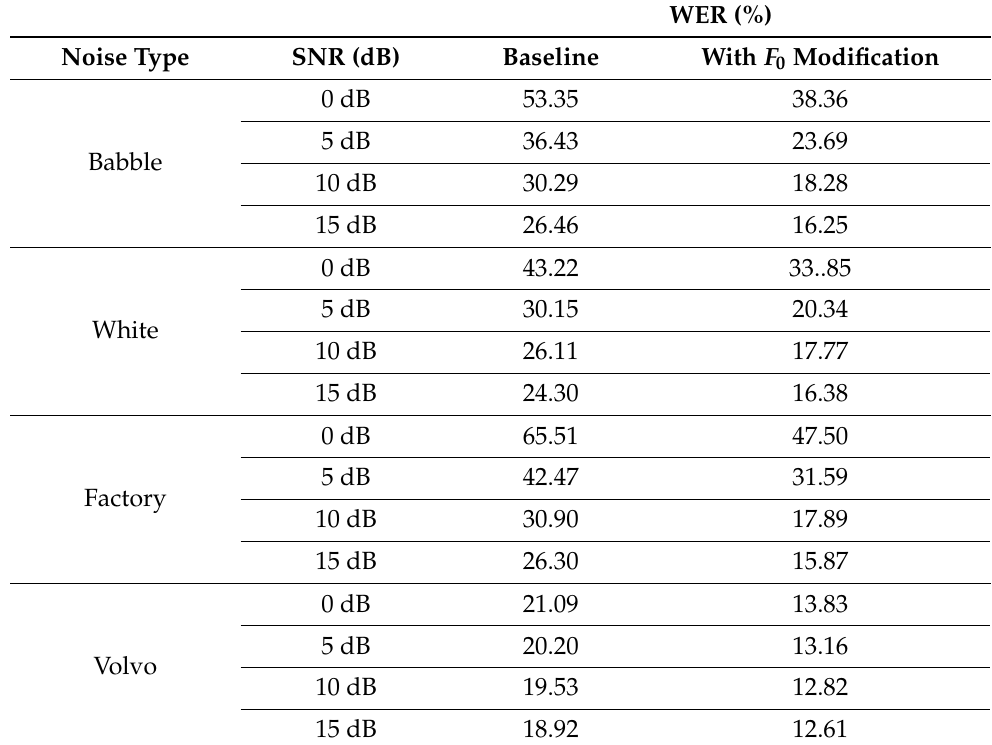
Figure 4. WERs as a function of the F 0 modification factor q for each of the four noise types and four SNR categories using the validation set. Note that the smaller the value of q (i.e., towards the right end of the x-axis), the larger the strength of the F 0 modification. Table 4. WERs obtained in recognizing noisy children’s speech of four noise types in four SNR categories using F 0 modification. The baseline system is the same as in Table